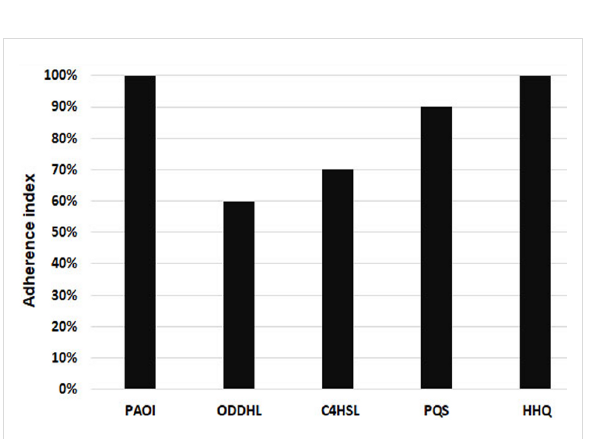
Figure 2: Graphic representation of the adherence index to cellular substrata of PAO1 strain treated with 20 µM of tested purified QSSMs.